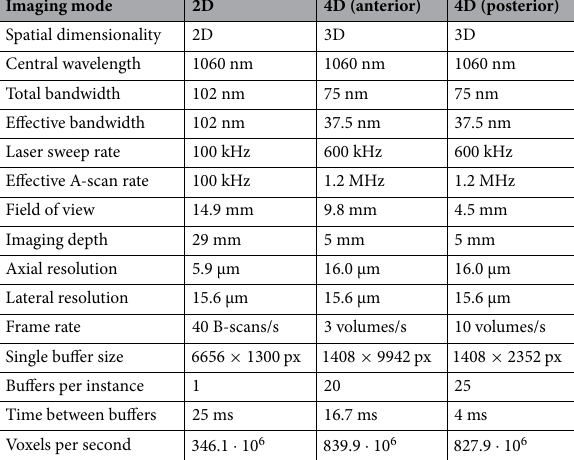
Table 1. Acquisition modes of the 4D-OCT prototype 31 . For the 4D modes, doubling of the effective A-scan rate is achieved by spectral splitting 32 , halving the effective bandwidth. Resolutions are given as full width at half maximum (FWHM) in